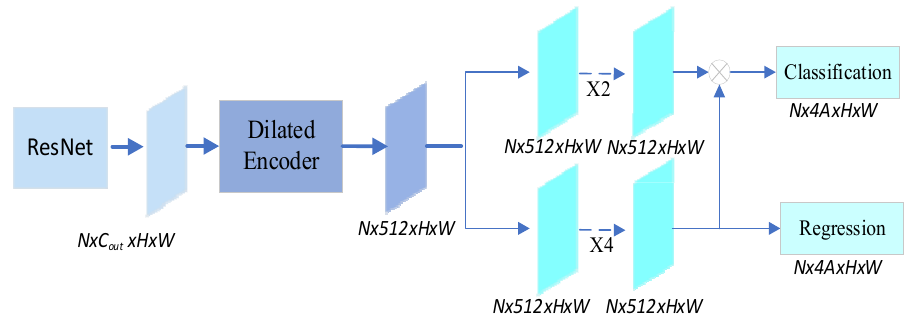
Figure 1. The sketch of YOLOF [33].